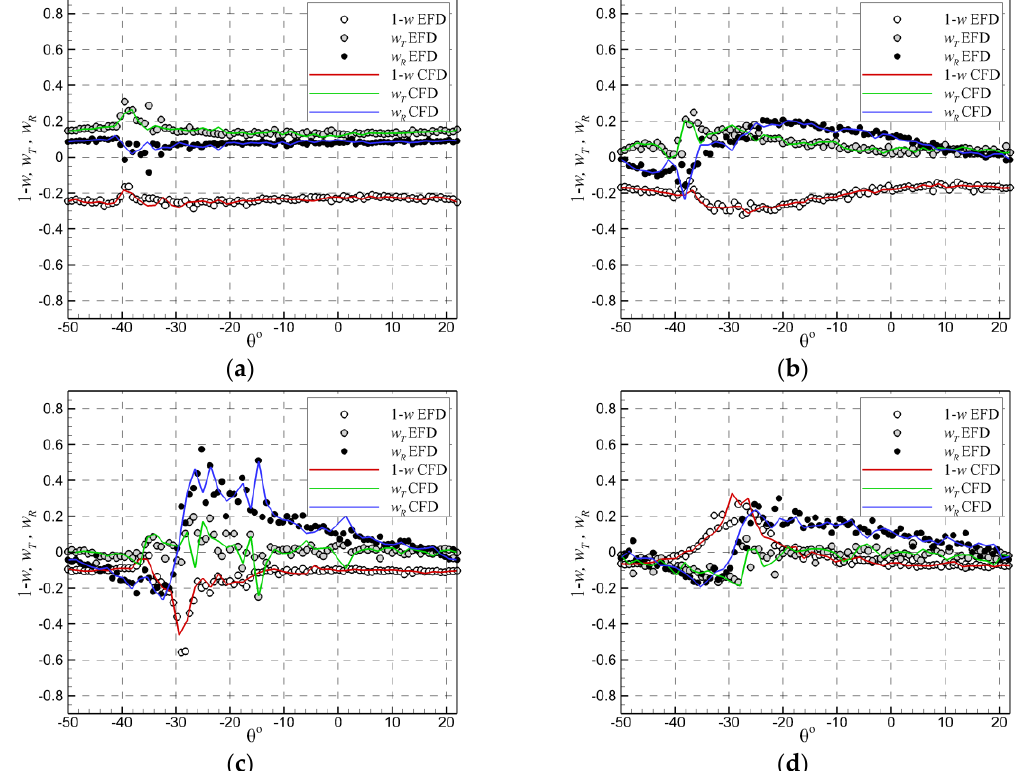
Figure 13. Comparisons between the wake components measured [44] and computed at x / D =0.2. ( a ): r / R =0.7; ( b ): r / R =0.9; ( c ): r / R =0.97; ( d ): r / R =1.0.